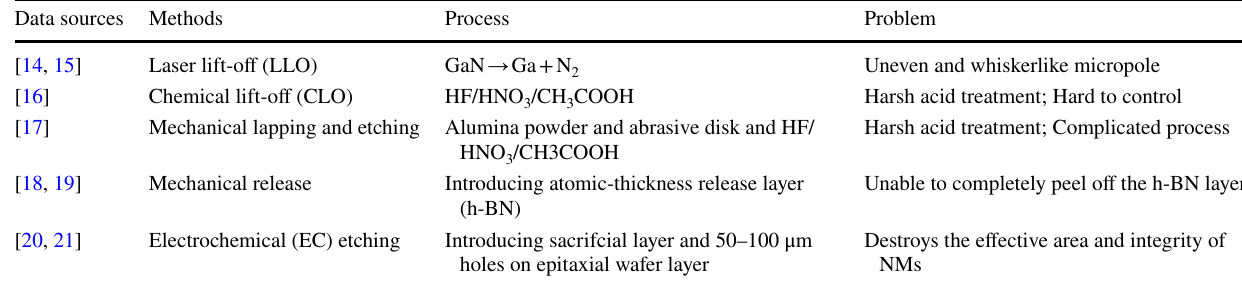
Table 1 Previous reported transfer methods on GaN based nanomembranes